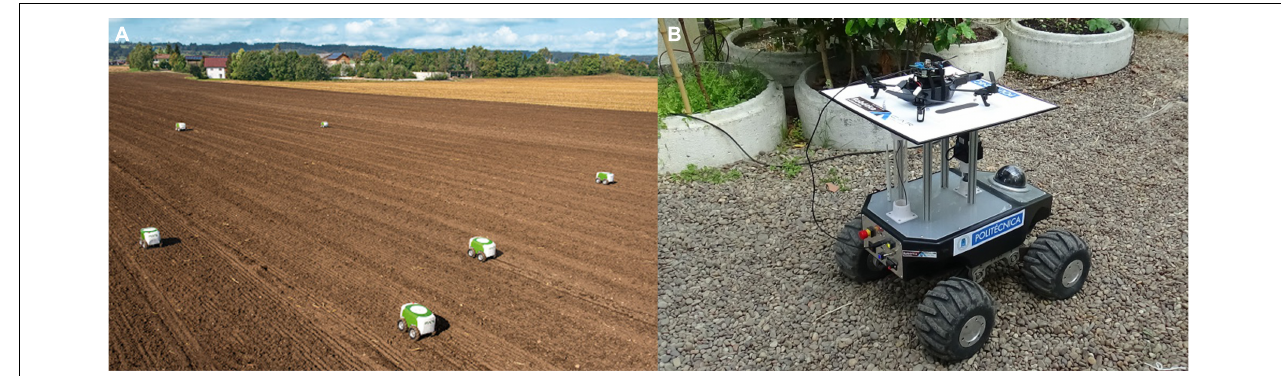
FIGURE 5 | (A) Mobile Agricultural Robot Swarms (MARS) for seeding process (The European Coordination Mobile Agricultural Robot Swarms (MARS). PDF file. November 11, 2016. http://echord.eu/public/wp-content/uploads/2018/01/Final-Report-MARS.pdf), (B) UAV-UGV cooperative system to measure environmental variables in greenhouse (Roldán et al.,